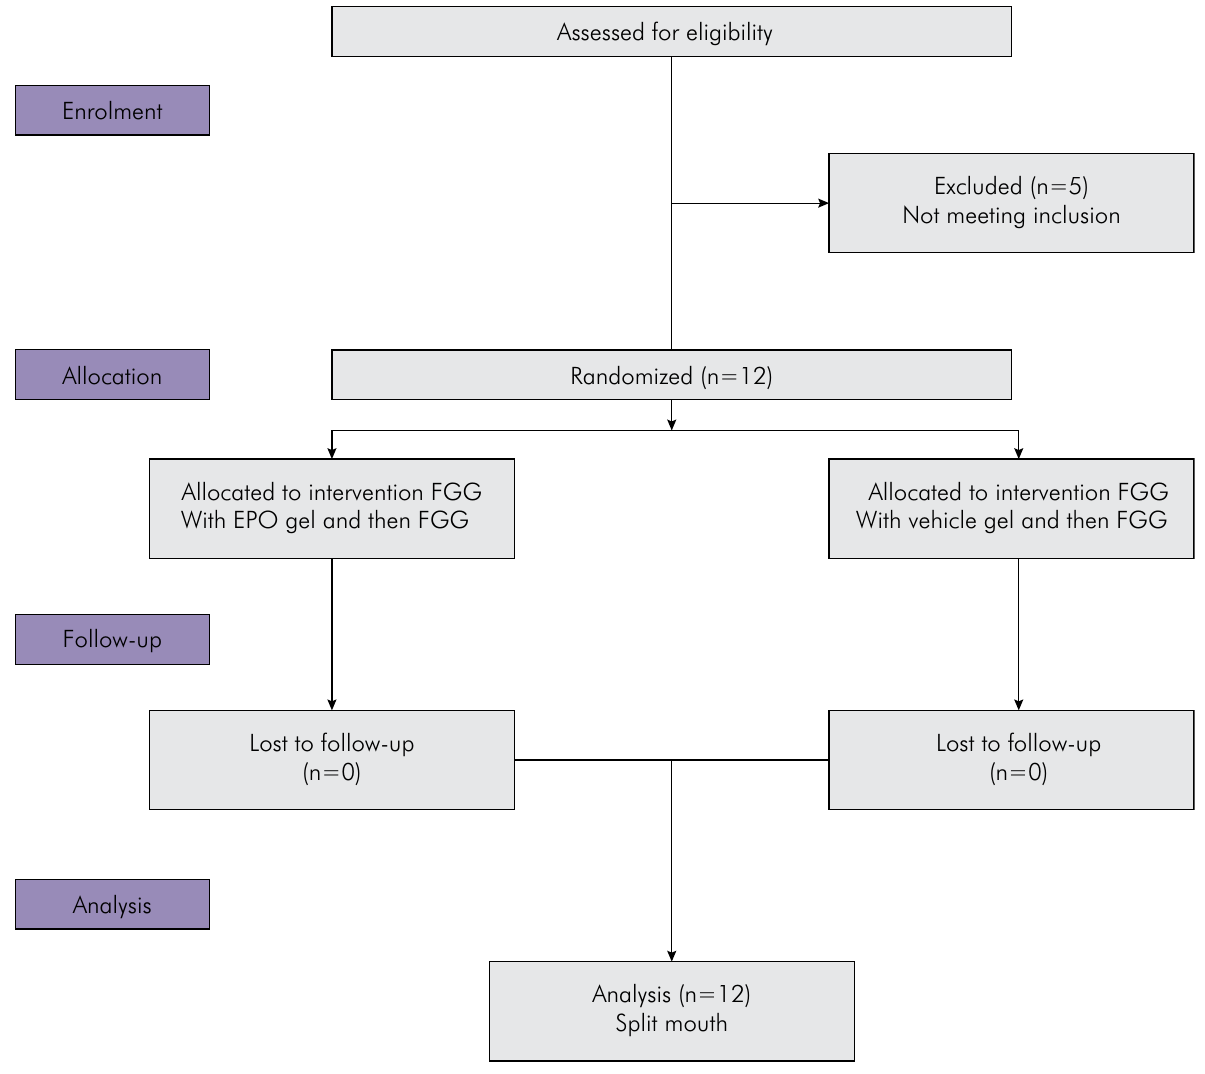
Figure 1. Clinical views of wound area, in the EPO and Control group: (a, b) harvesting free gingival graft; (c, d) 2 days after surgery; (e, f) healing on day 7; (g, h) healing on day 14; (i, j) healing on day 21; (k,l ) healing on day 28; and (m, n) healing on day